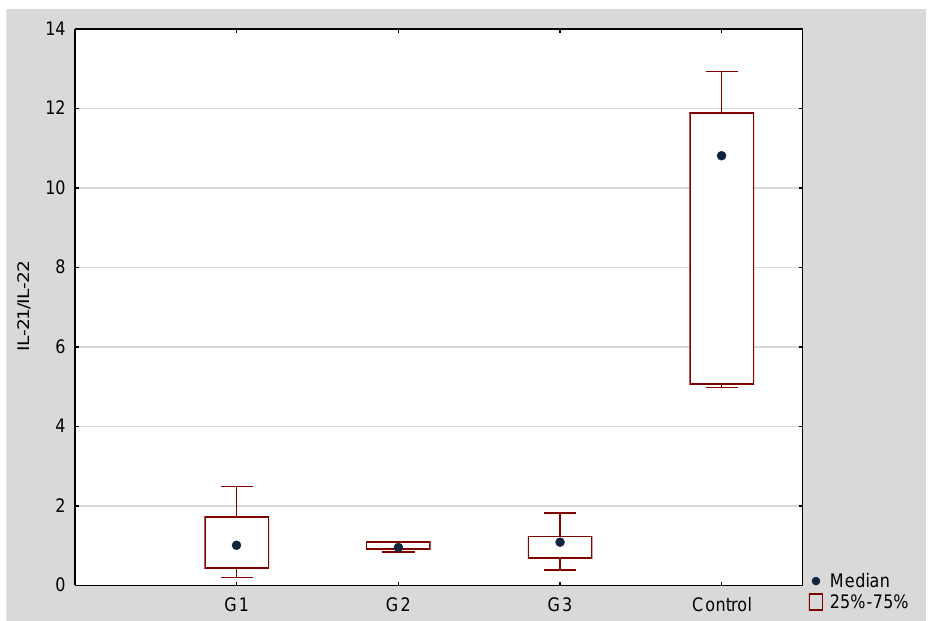
Figure 8. Linear regression curve showing the relationship between the concentration of Il-21 and IL-2 in the peritoneal fluid of women with ovarian cancer; r -correlation coefficient, p -probability value